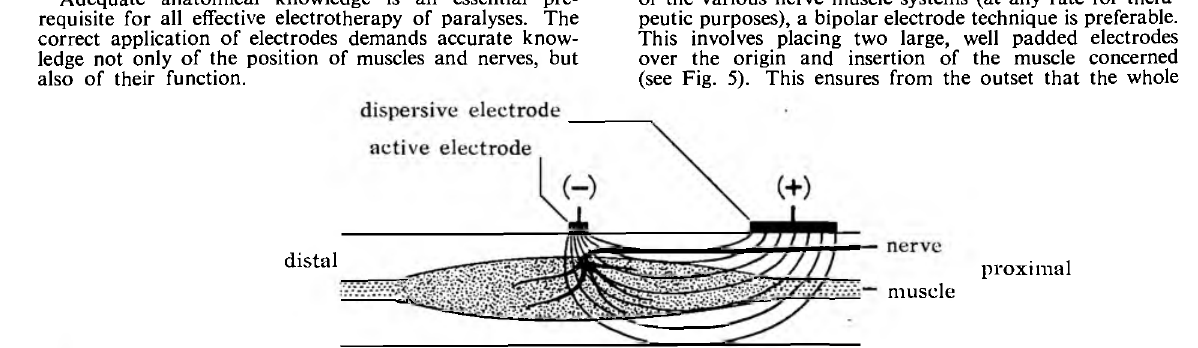
Fig. 4. Flow of the current, with unipolar stimulation, starting from the motor point. Only one half of the muscle is